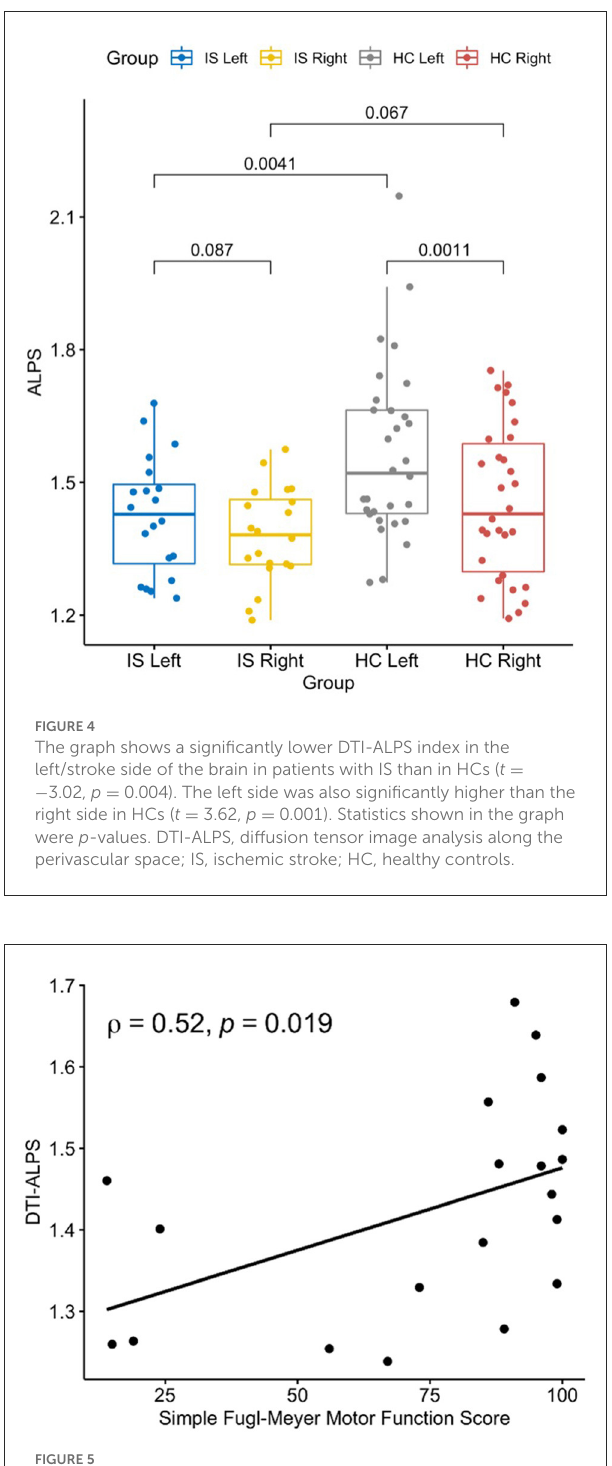
FA of the right CC ( R = 0.035, p = 0.88), the left DTI-ALPS index and the mean FA of the left CC ( R = 0.27, p = 0.26), and the